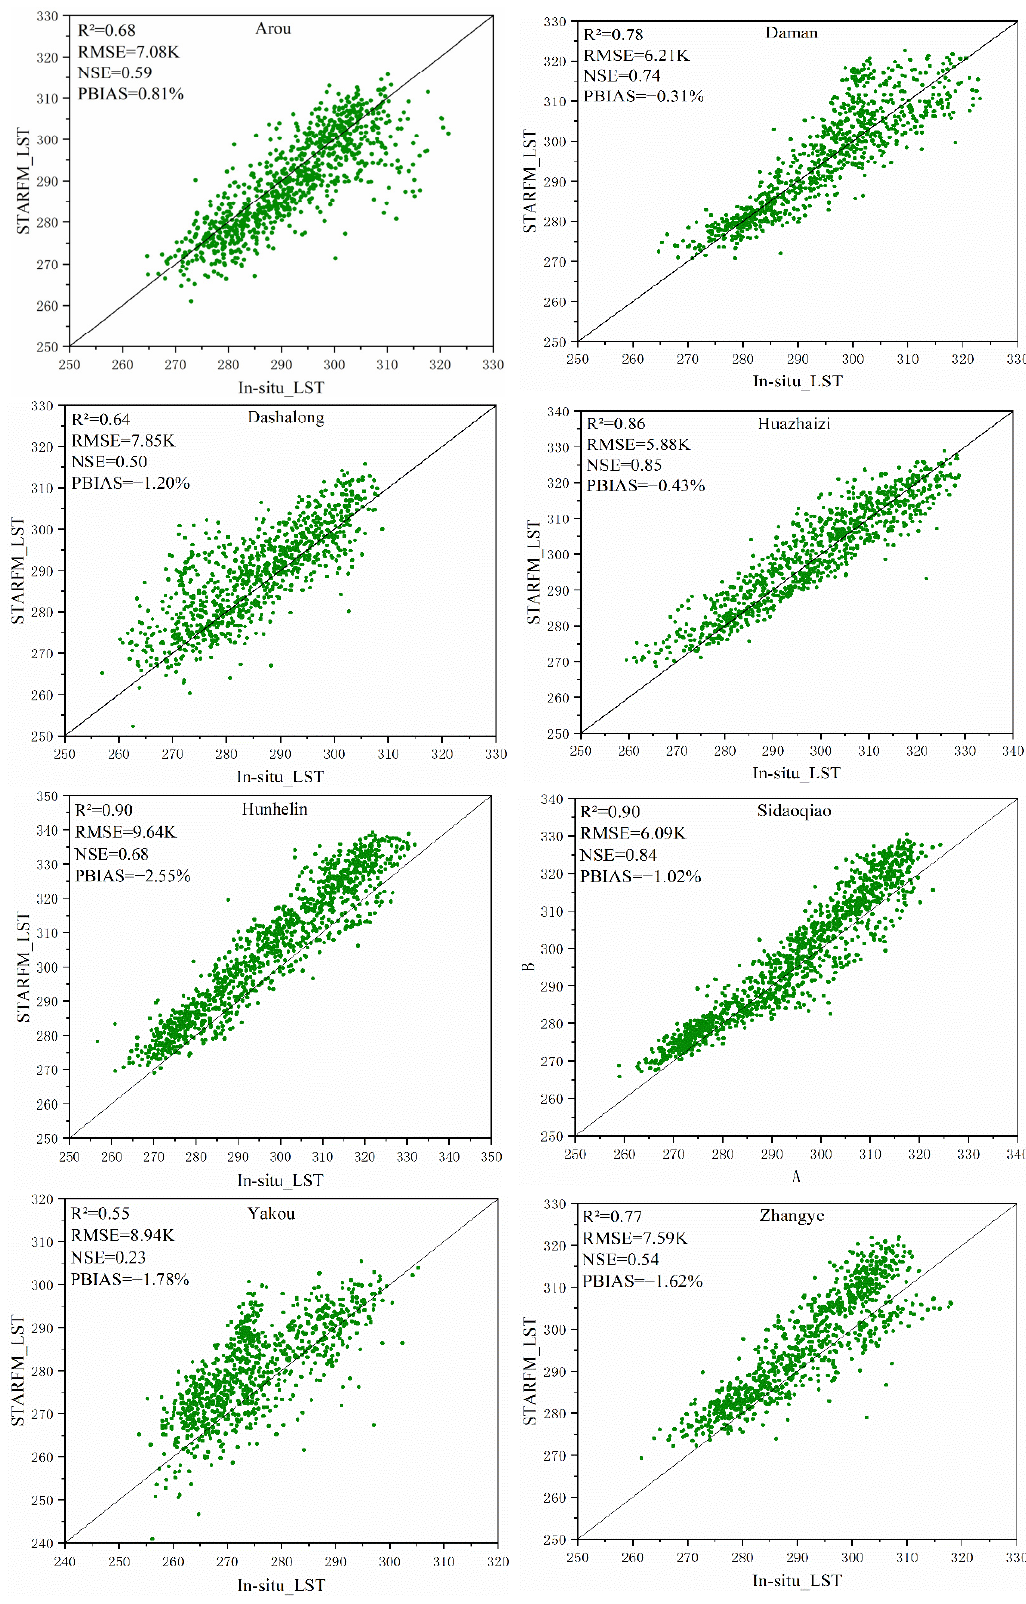
Figure 6. Validation of LST fused by STARFM based on AMSR2 from 2016 to 2019.